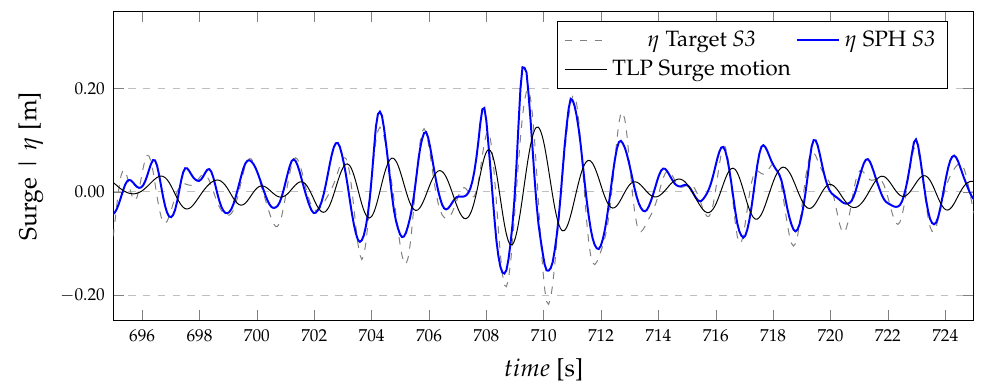
Figure 9. Surface elevation comparison between the generated wave for Sea State S3 and the theoretical second-order solutions (dashed black lines). Note that the numerical data refers to a gauge located aside the TLP. The solid black line reports the TLP surge motion.